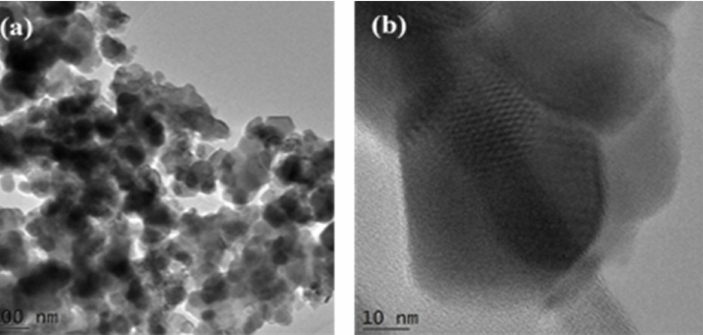
Figure 14. TEM image ( a ) and HRTEM ( b ) image of pyrolytic product from the precursor PSP-co-4- PVP · (Ce(NO 3 ) 3 ) n .